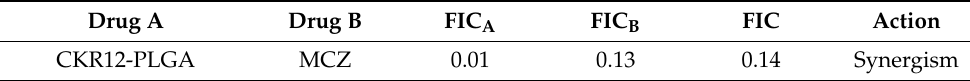
Table 2. Combined activity of CKR12-PLGA and